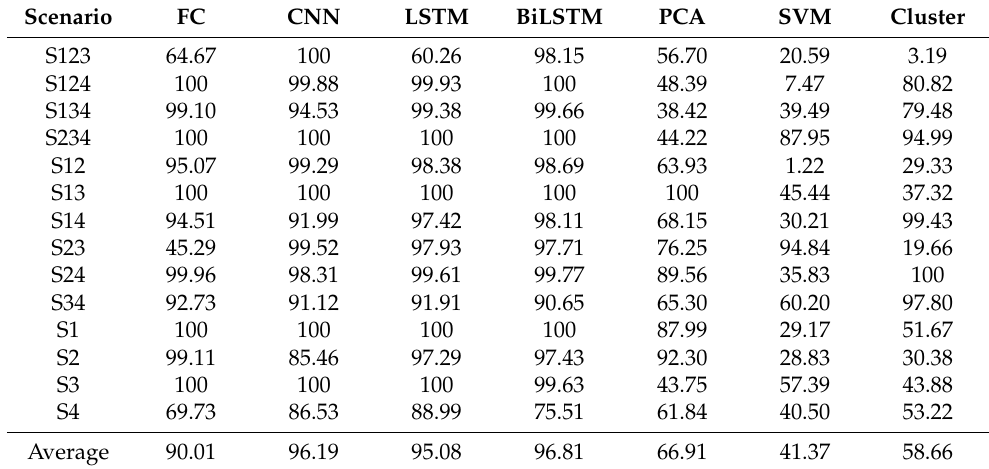
Table 7. Evaluation of the effectiveness in operating conditions with anomalies: average F1 score.